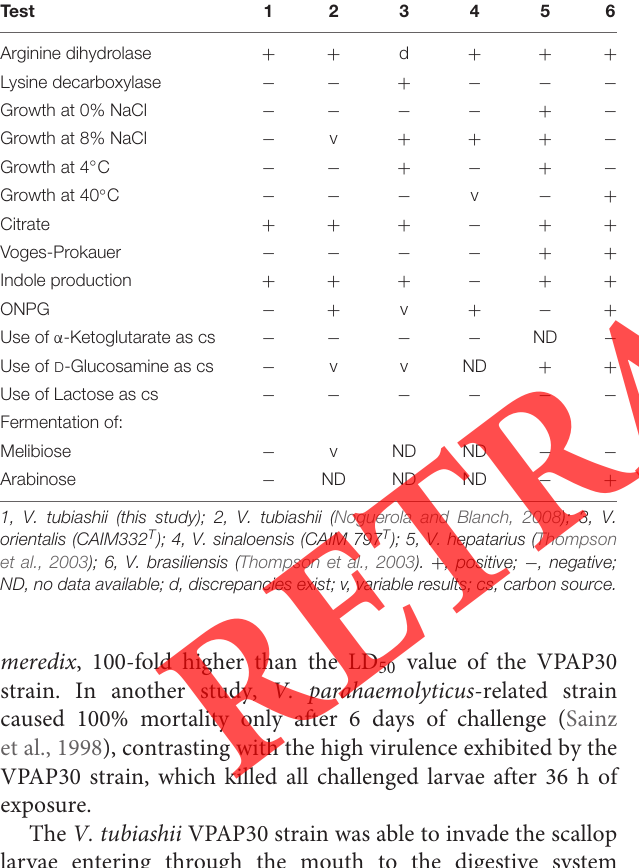
TABLE 4 | Comparative phenotypic characteristics of V . tubiashii (VPAP30) and Vibrio species belonging to Orientalis Clade.